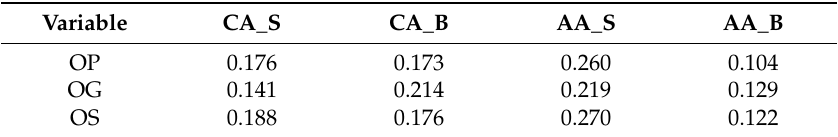
Table 14. Standardized indirect effects.